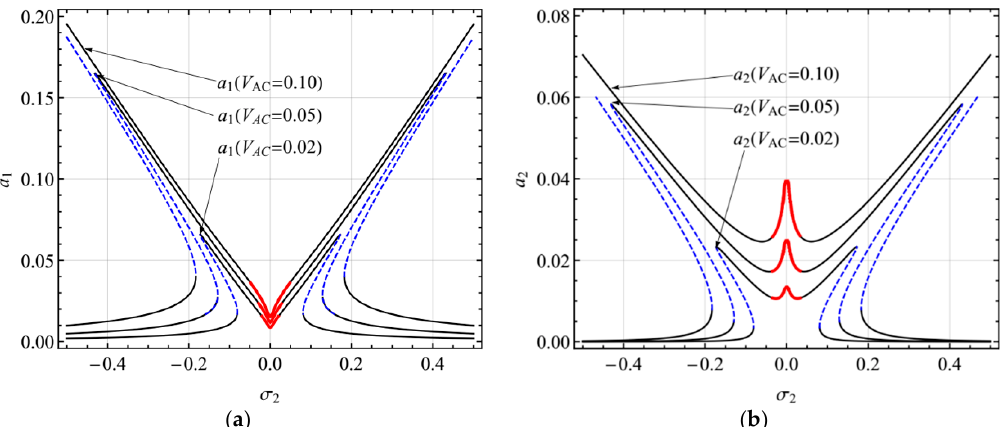
Figure 3. Frequency-response curves of primary resonance of the first mode for V AC = 0.02, 0.05, 0.10: ( a ) the first mode, ( b ) the second mode.